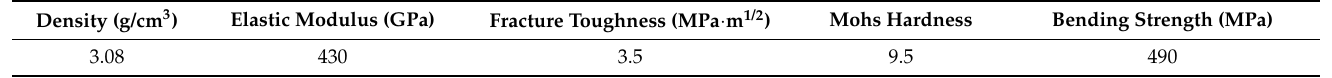
Table 1. Material properties of RB-SiC